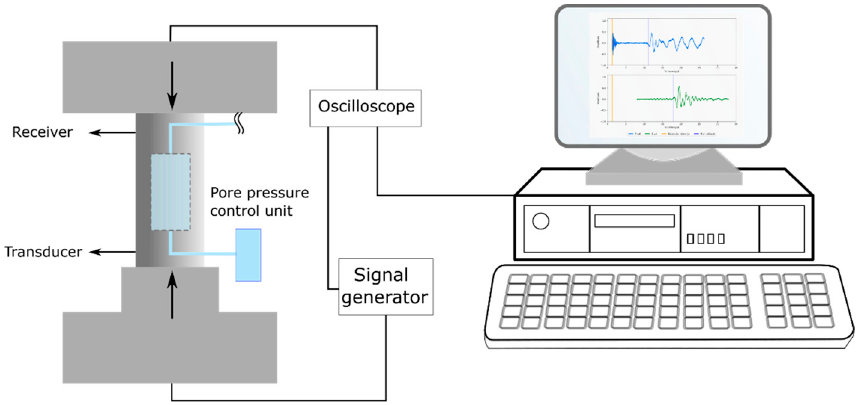
Figure 2. Illustration of the ultrasonic velocity measurement device.